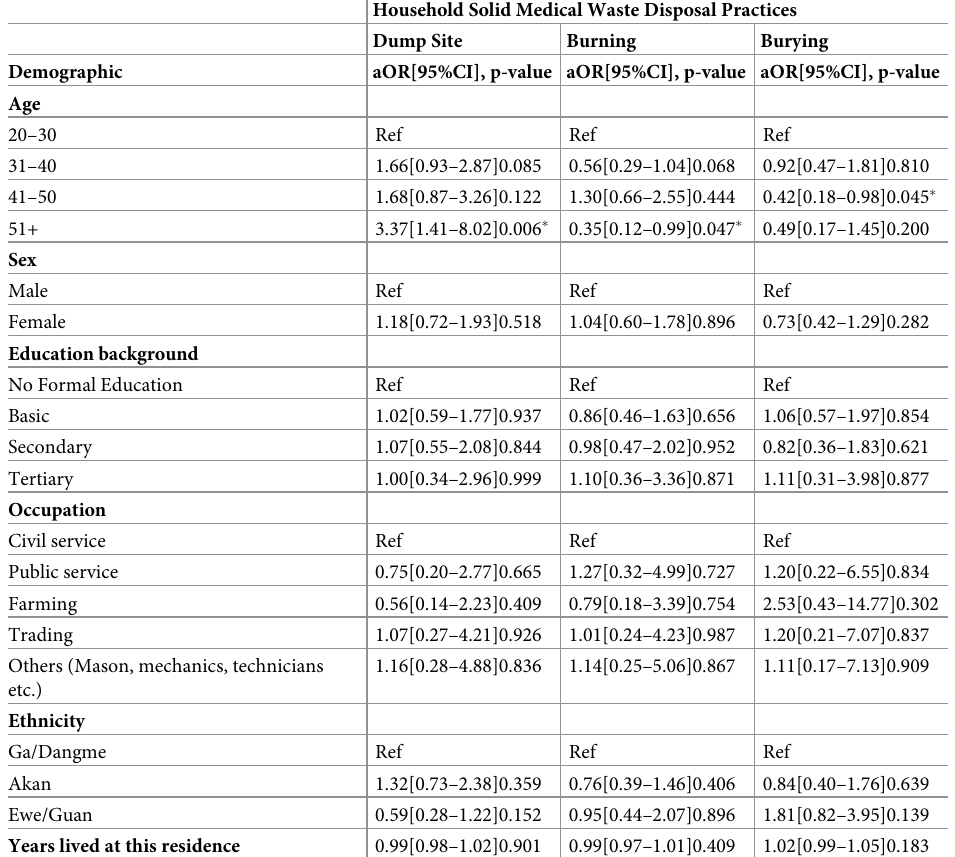
Table 6. Relationship between disposal practices and sociodemographic characteristic of household